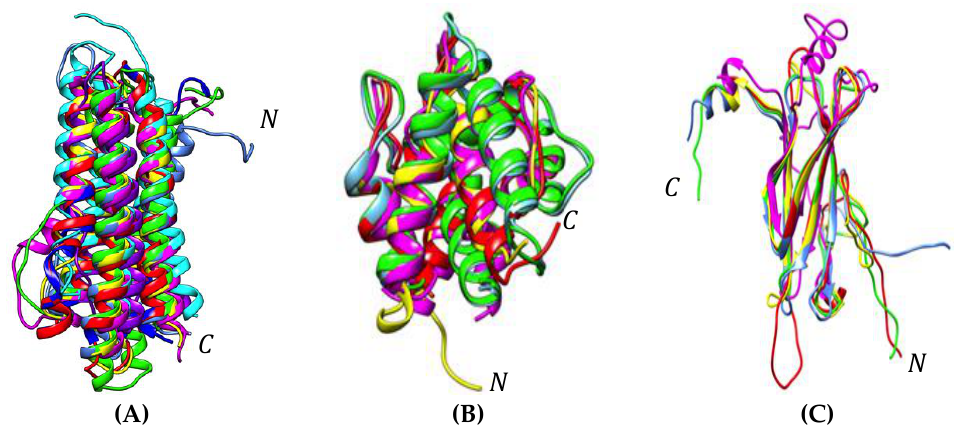
Figure 6. ( A ) Superposition of the di ff erently colored three-dimensional models of apoLP-III of the edible insects Acheta domesticus (blue) , Bombyx mori (green) , Galleria mellonella (magenta) , Locusta migratoria (yellow) , Manduca sexta (deep blue) , Musca domestica (cyan) , Schistocerca gregaria (purple), and Tenebrio molitor (red). ( B ) Superposition of the di ff erently colored three-dimensional models of 12 kDa HLP and OBP of the edible insects Tenebrio molitor (red), Bombyx mori (blue), Manduca sexta (green), Onchorhynchus ferrugineus (magenta), and Apis mellifera (yellow). ( C ) Superposition of the di ff erently colored three-dimensional models of cuticle protein of the edible insects Tenebrio molitor (red), Bombyx mori (green), Locusta migratoria (magenta), Musa domestica (yellow), and Tribolium castaneum (blue). N and C indicate the N - and C -terminal ends of the polypeptide chains.